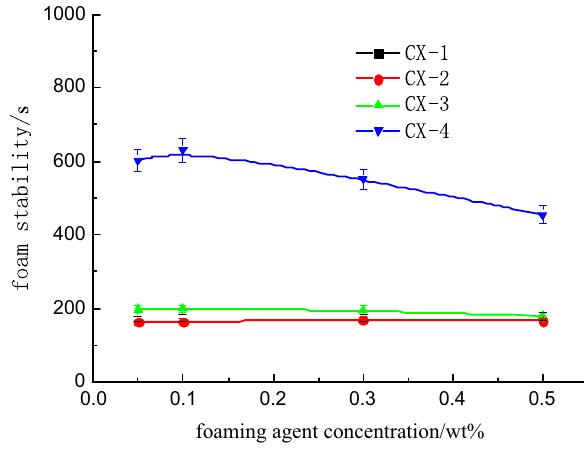
Figure 2: Foam stability of the foaming agent at